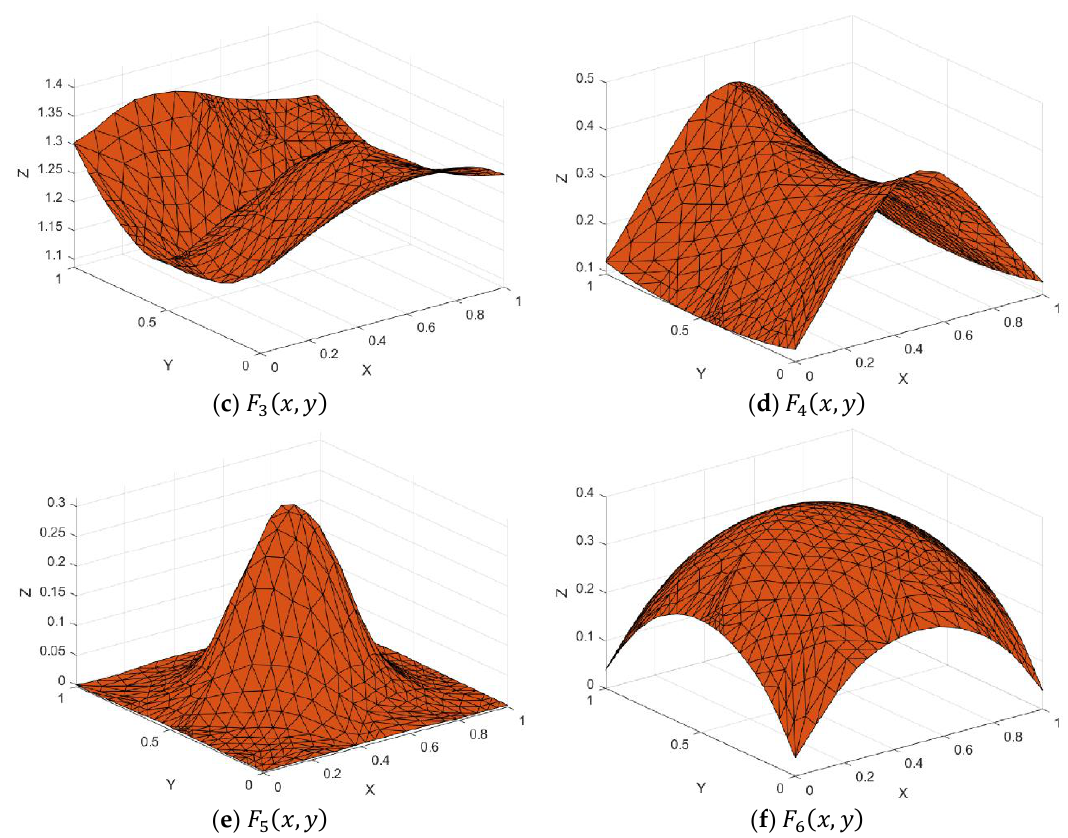
Figure 19. Surface interpolation using Foley and Opitz method and Choice 2 for 65 datasets.